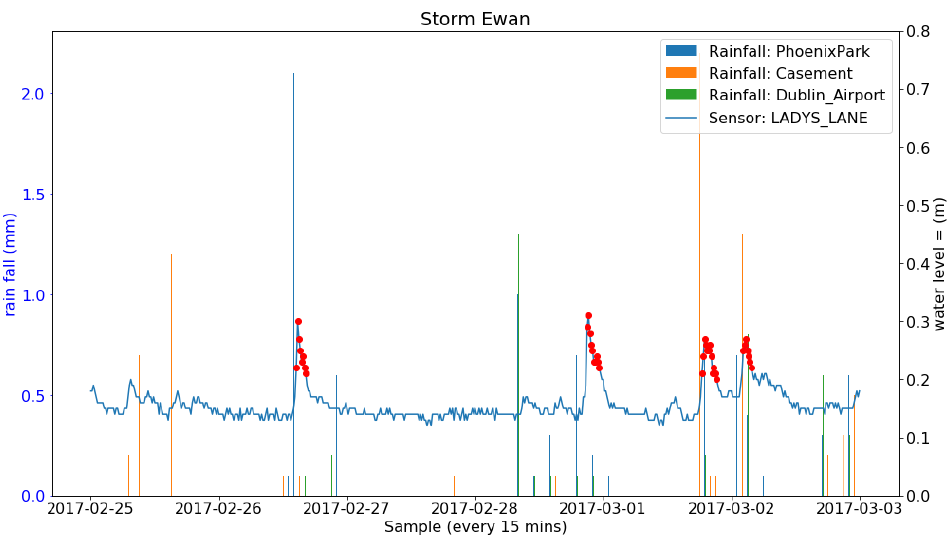
Figure 16. Rainfall from three Met Éireann weather stations and the water level sensor measurements along with the anomalies detected and the four events constructed during the Storm